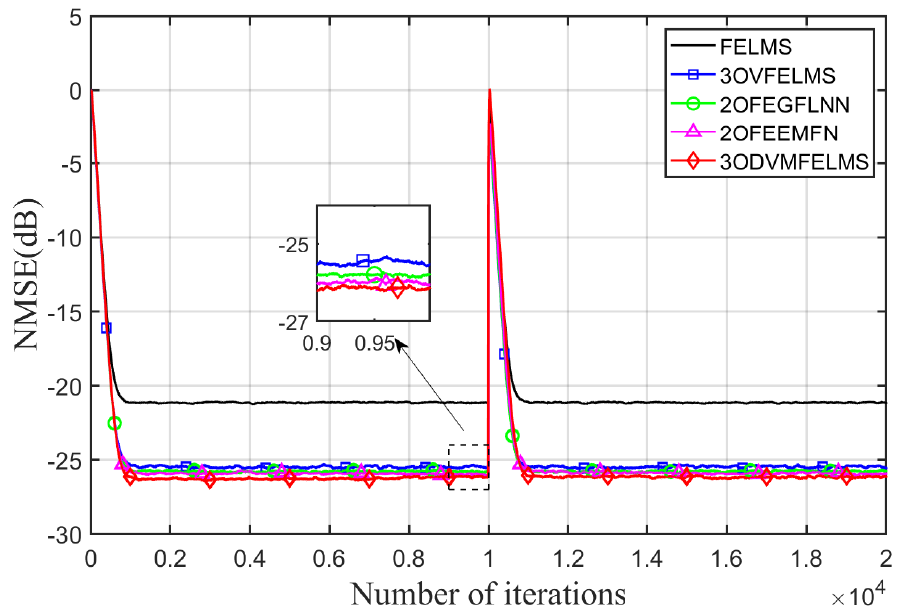
Figure 4. Performance comparison using the nonlinear primary path with sinusoidal reference